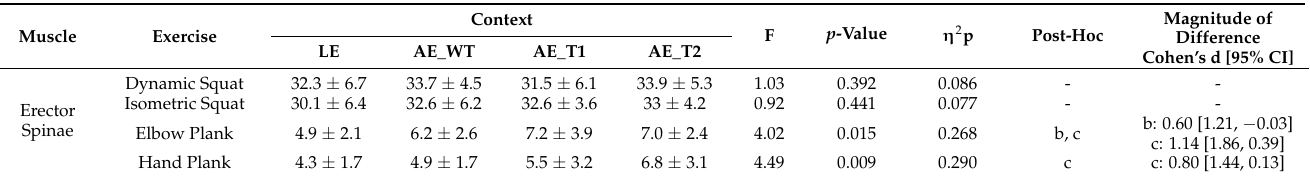
Table 2. Descriptive analysis (mean ± standard deviation) of EMG magnitude (%) and inferential analysis of the activation of the erector spinae muscle as a function of the exercises and taking into account the context